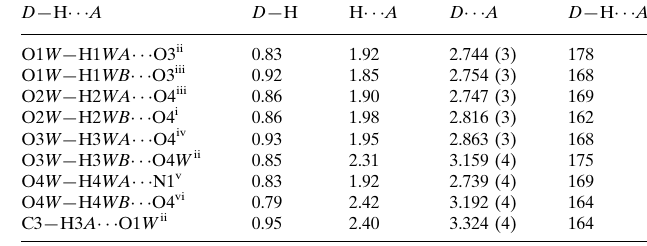
Hydrogen-bond geometry (A˚ , (cid:2)